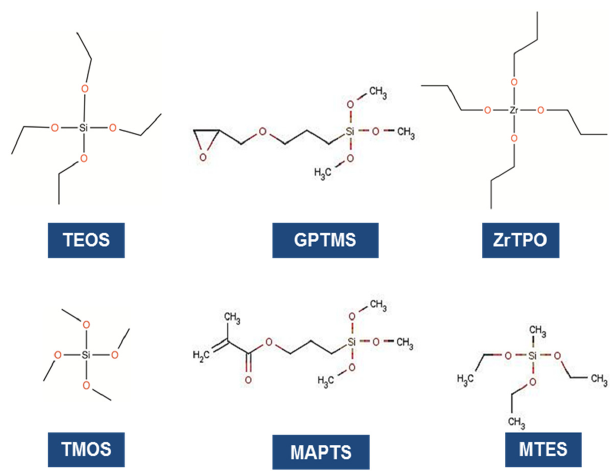
Figure 5. Examples of precursors used in the synthesis of hybrid materials.